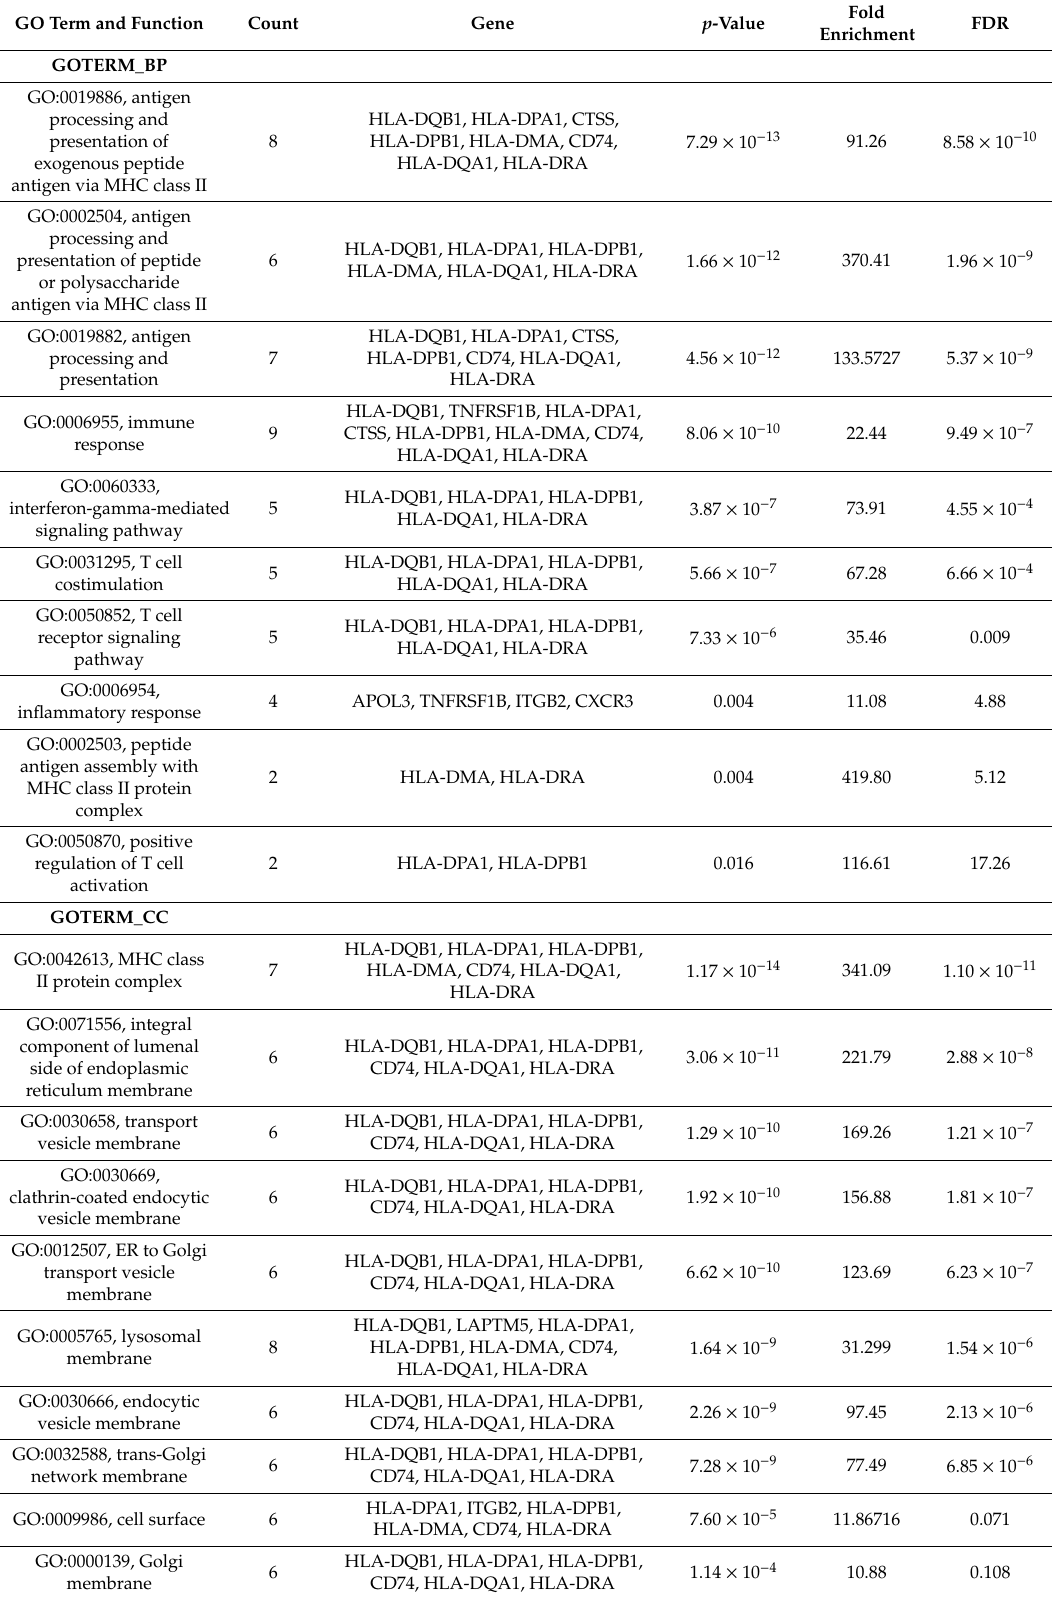
Table 6. Gene ontology (GO) enrichment analysis of HLA-DPA1 and -DRA co-expressed genes by the Database for Annotation, Visualization and Integrated Discovery